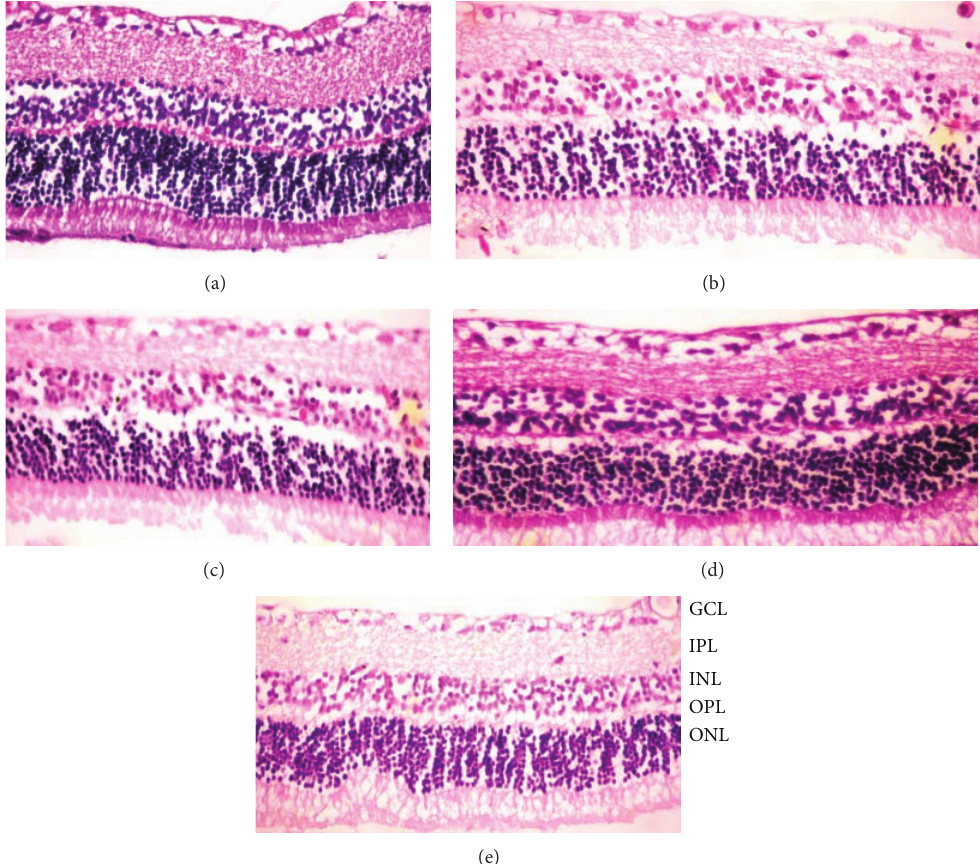
Figure 1: (a) In controls, normal retina architecture was seen; (b) after ischemic injury, severe retinal damage was noted; (c) ischemic injury plus DMSO group, observed reduction in retinal thickness and injuries; (d and e) there was an improvement in the retinal structure in hesperetin-treated and naringenin-treated ischemic rats, respectively. Retina thickness had increased significantly after in the hesperetin- and naringenin-treated compared to ischemic rats. Haematoxylin and eosin staining ( ×